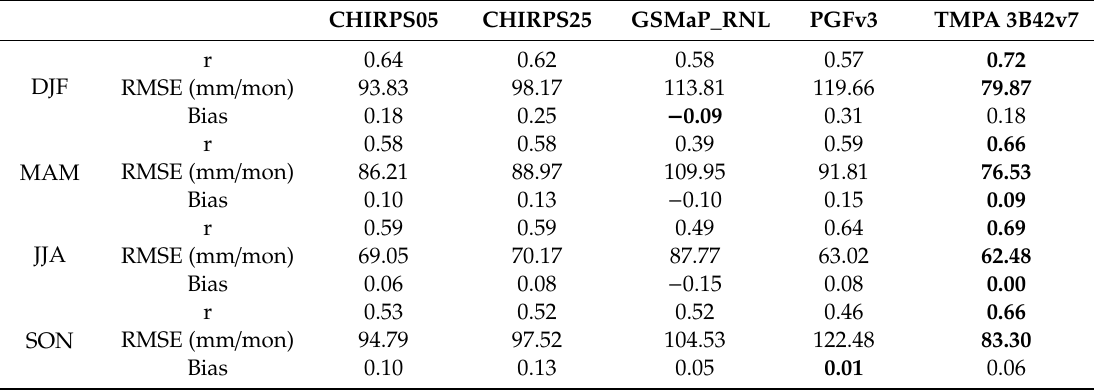
Table 5. Seasonal values of statistical measures of CHIRPS05, CHIRPS25, GSMaP_RNL, PGFv3 and TMPA 3B42v7. The best values for each indicator are in